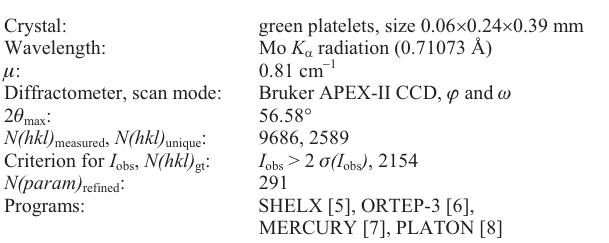
Table 1. Data collection and